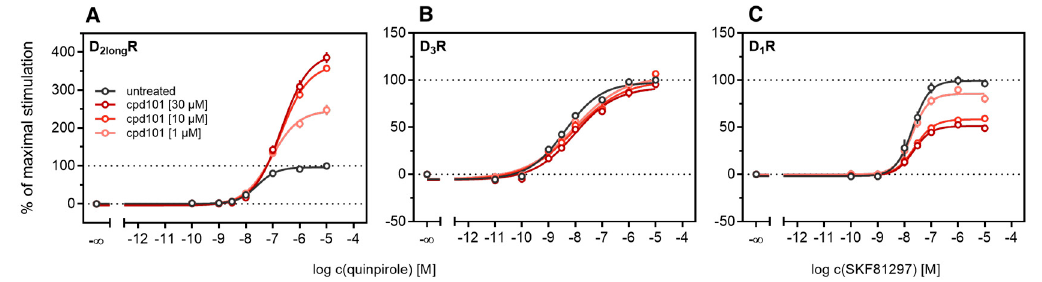
Figure 6. Influence of the GRK2/3 inhibitor cpd101 on β -arrestin2 recruitment. HEK293T cells stably expressing ELucN- β arr2 and the indicated D x R-ELucC were incubated with cpd101 at different concentrations for 40 min prior to agonist addition ( A – C ). Data represent means ± SEM from three independent experiments, each performed in triplicate.